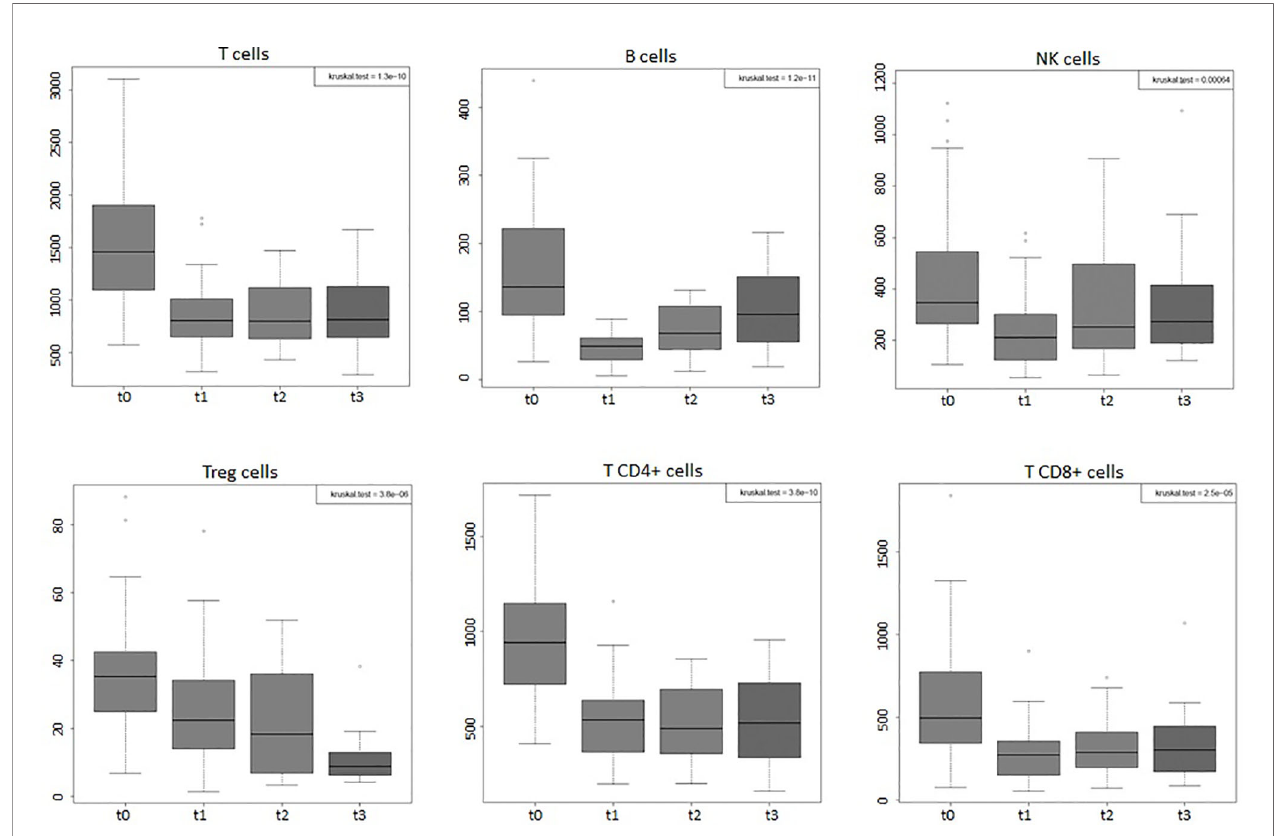
FIGURE 2 | Boxplots of the absolute values of total T, B, NK, Tregs, T CD4, and T CD8 cells of the entire group of prostate cancer patients (44) undergoing curative RT. The data shown evidenced variations statistically signi fi cant during the four time points considered (Kruskal – Wallis test, p -value < 0.001). t0: before RT; t1: end of RT; t2: 3 months after RT; t3: 6 months after RT. All values are expressed as